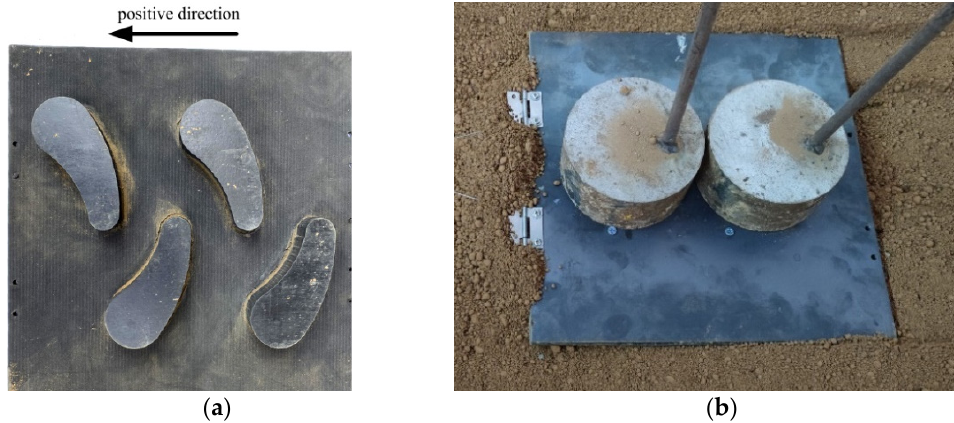
Figure 9. Test direction and load: ( a ) pattern direction; ( b ) apply 100 N load.